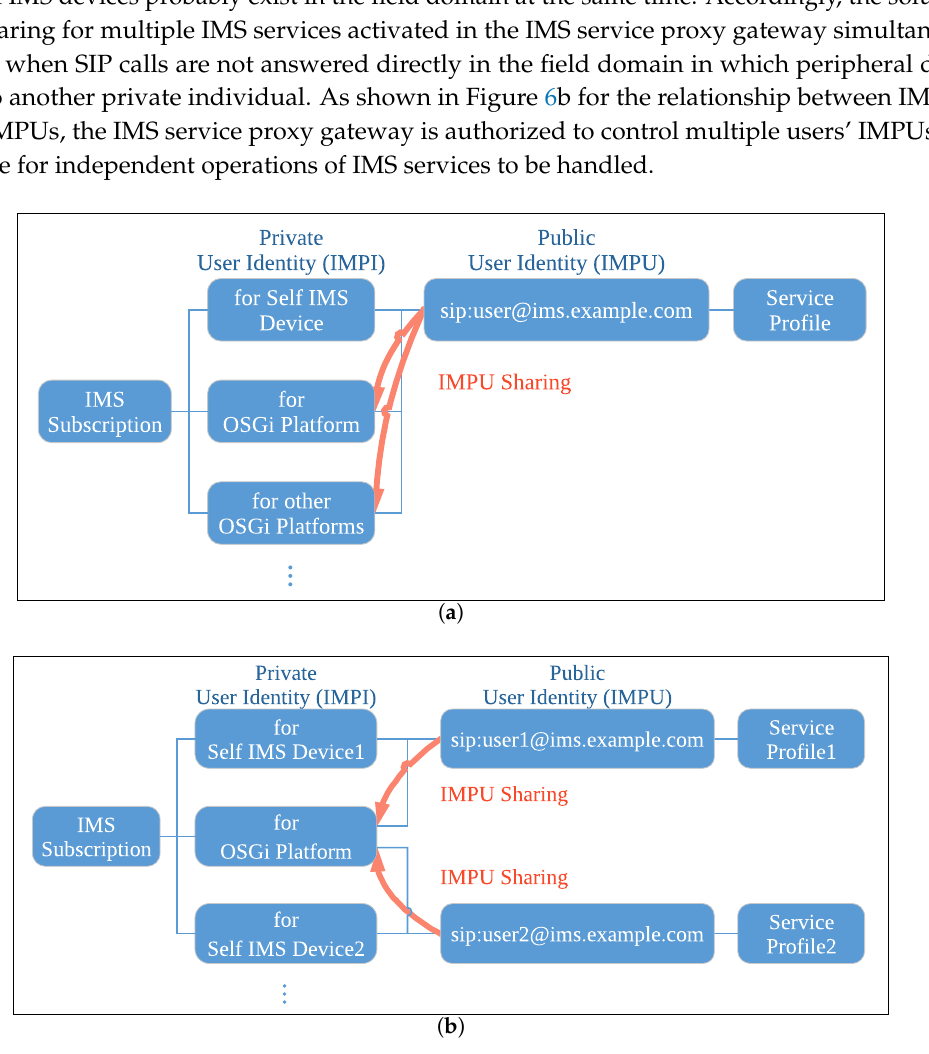
Figure 6. The relationship between IMPI and Shared IMPUs for ( a ) a personal self IMS device and the proxy gateway; and ( b ) multiple personal self IMS devices and the proxy